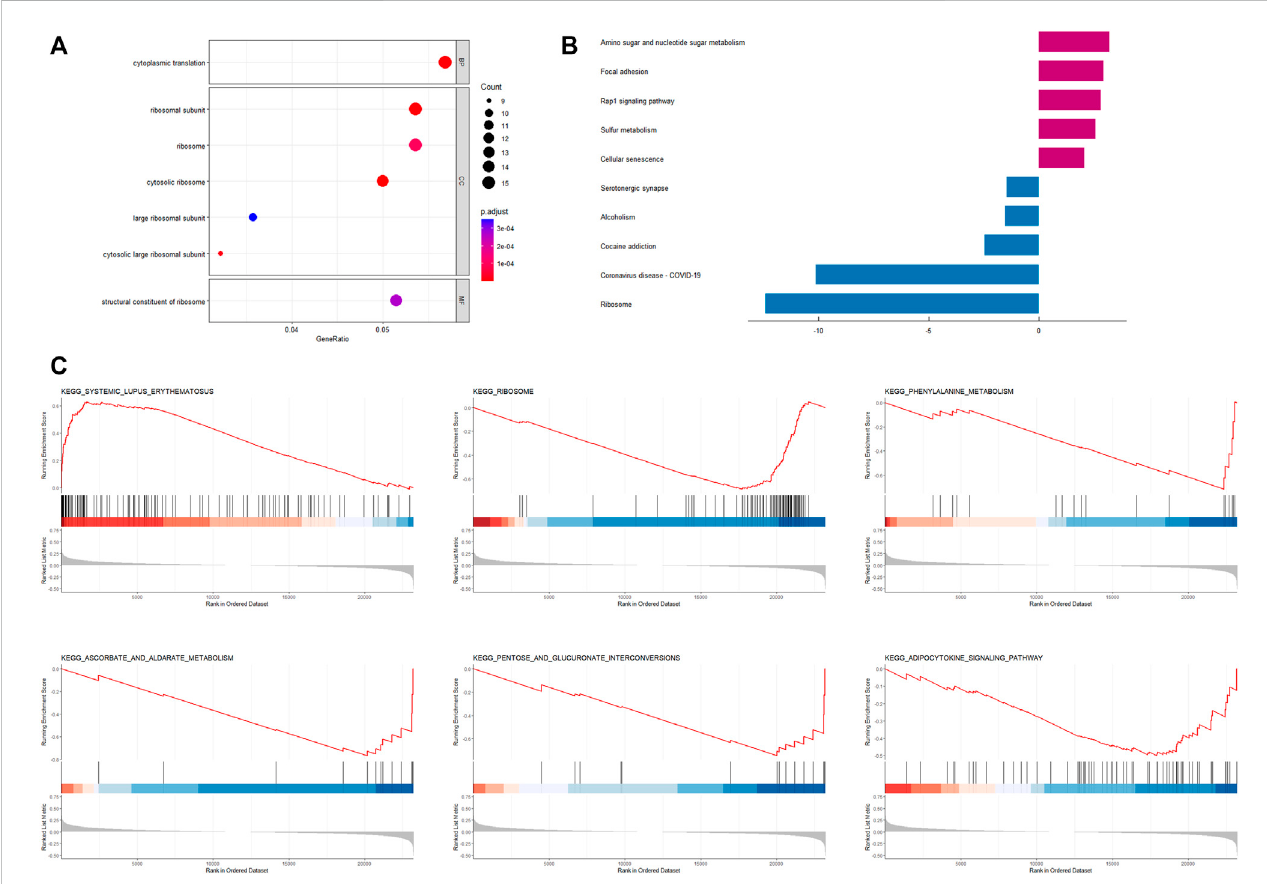
FIGURE 6 Enrichment analysis based on CRRGs risk model (A) Bubble plot for GO enrichment analysis based on CRRGs. (B) Bar chart of KEGG enrichmentanalysis based on CRRGs. (C) Gene enrichment analysis of CRRGs in the TCGA-BRCA dataset.